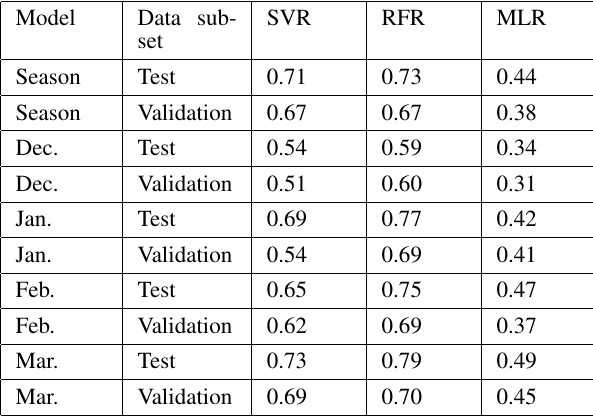
Table 4. Comparison of actual and downscaled soil